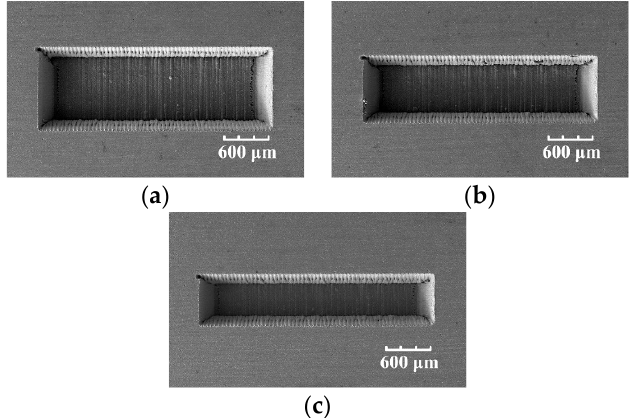
Figure 10. SEM of workpieces of different widths processed by blowing-assisted laser processing, shown after ultrasonic cleaning: ( a ) width of 1 mm, ( b ) width of 0.8 mm, ( c ) width of 0.6 mm.